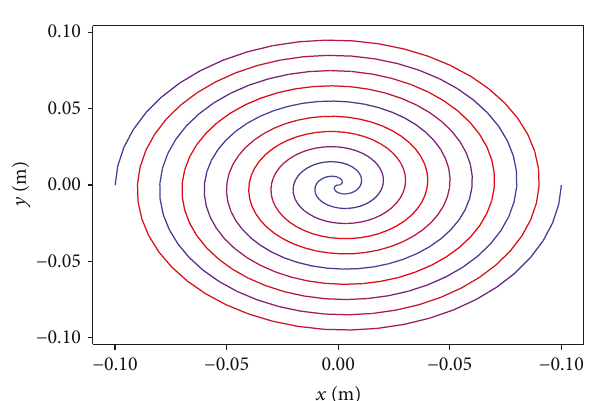
Figure 12: The amplitude distribution of current on the x - y plane.